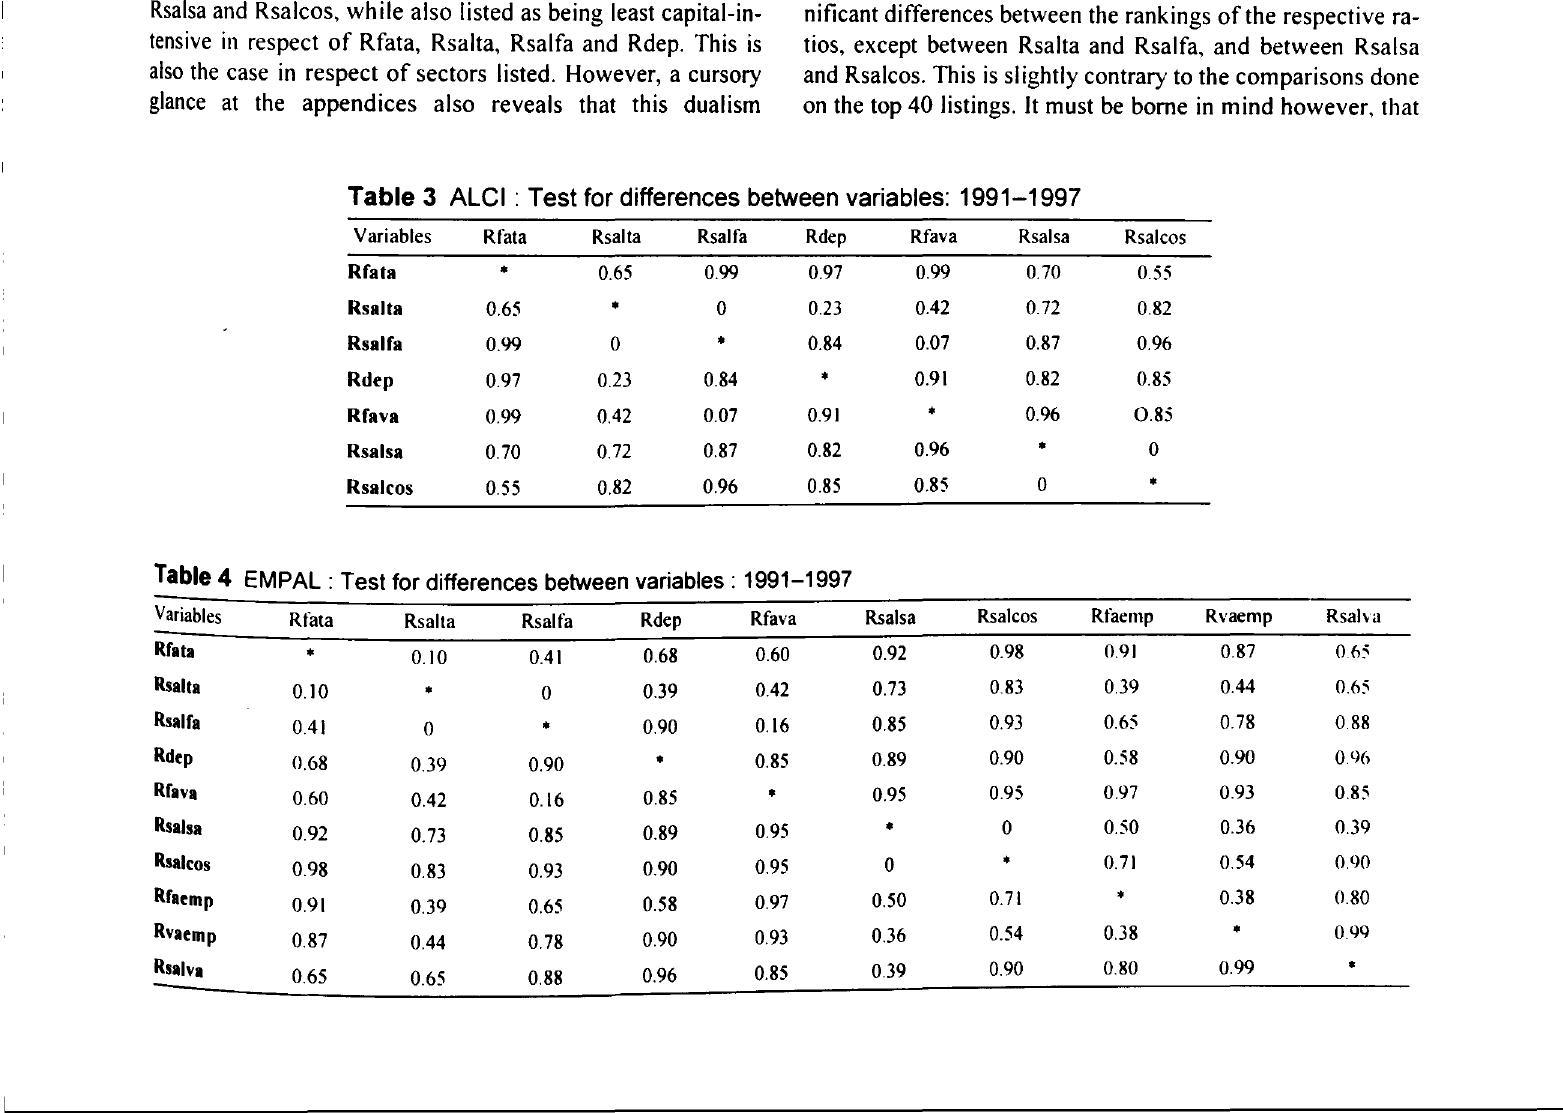
Table 3 ALCI: Test for differences between variables: 1991-1997